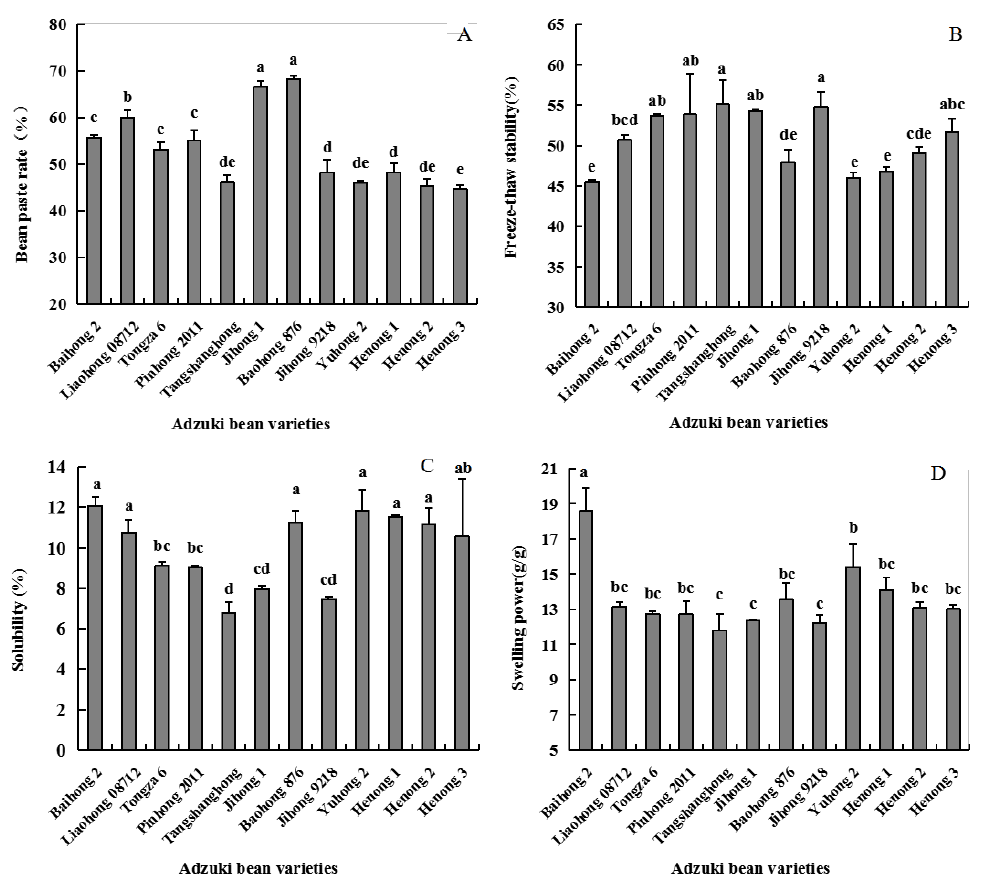
Figure 3. The bean paste rate, freeze-thaw stability, solubility, and swelling power of different adzuki bean varieties. Note: Different lowercase letters indicate significant difference of 0.05 level, LSD method. A: Bean paste rate of adzuki bean flour (%); B: Freeze-thaw stability of starch (%); C: Solubility of starch (%); D: Swelling power of starch (g/g)